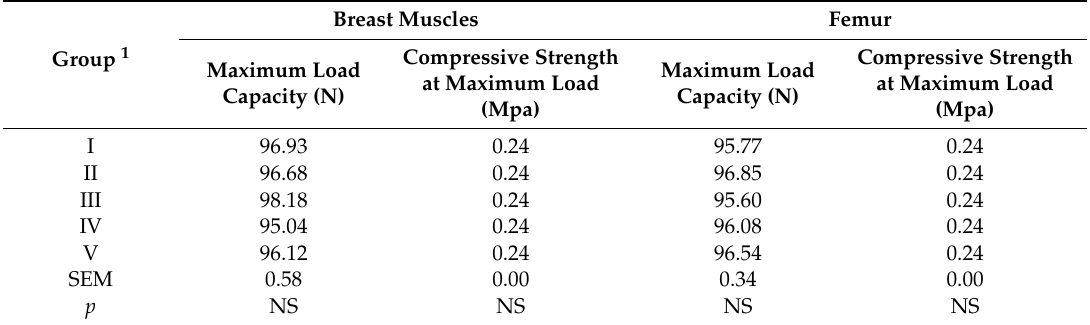
Table 8. Elasticity of breast muscles (N) and strength of femoral bones (N) in 7-week-old ducks *. Breast Muscles Femur Compressive Strength Compressive Strength Group 1 Maximum Load Maximum Load at Maximum Load at Maximum Load Capacity (N) Capacity (N) (Mpa) (Mpa) I 96.93 0.24 95.77 0.24 II 96.68 0.24 96.85 0.24 III 98.18 0.24 95.60 0.24 95.04 0.24 96.08 0.24 V 96.12 0.24 96.54 0.24 SEM 0.58 0.00 0.34 0.00 p